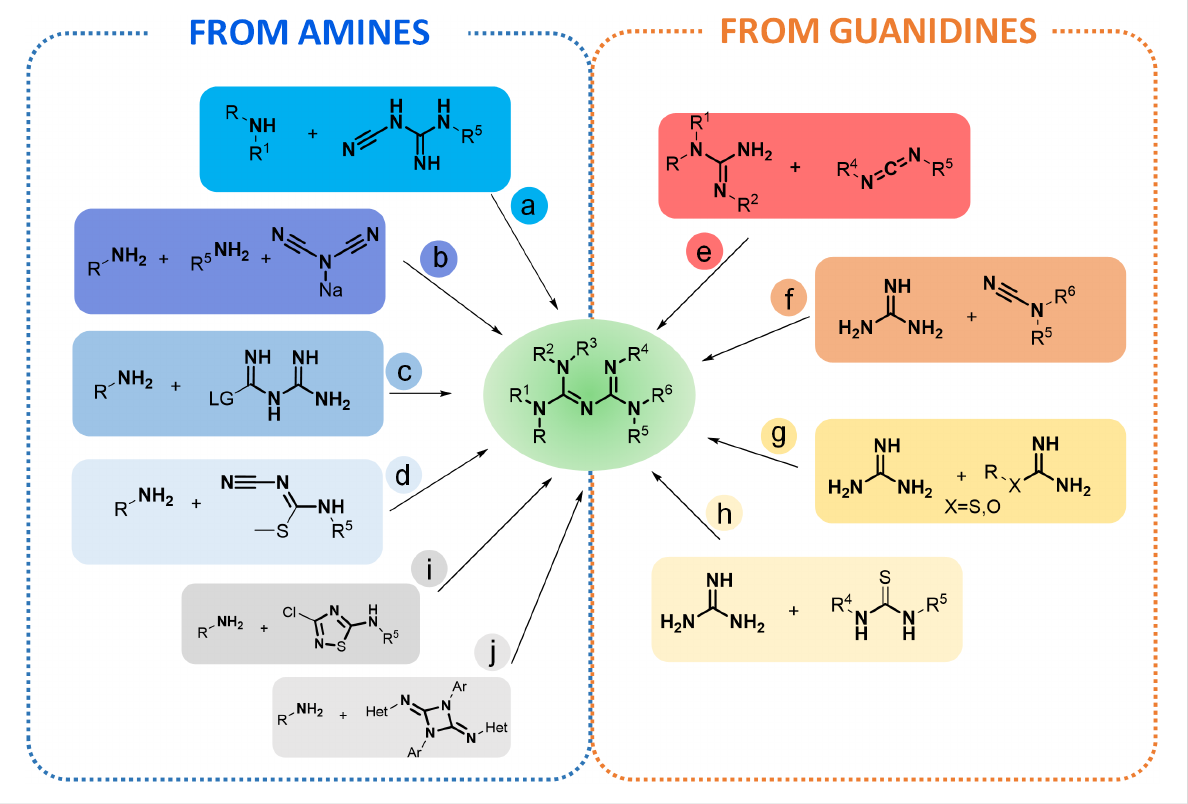
Figure 3: The main approaches for the synthesis of biguanides. The core structure is obtained via the addition of amines to cyanoguanidines (path- way a), dicyanamides (pathway b), carbamide (pathway c) or N 1 -cyano -S -methylisothioureas (pathway d), and by the addition of guanidines to carbodiimides (pathway e), cyanamides (pathway f) or (iso)(thio)ureas derivatives (pathways g and